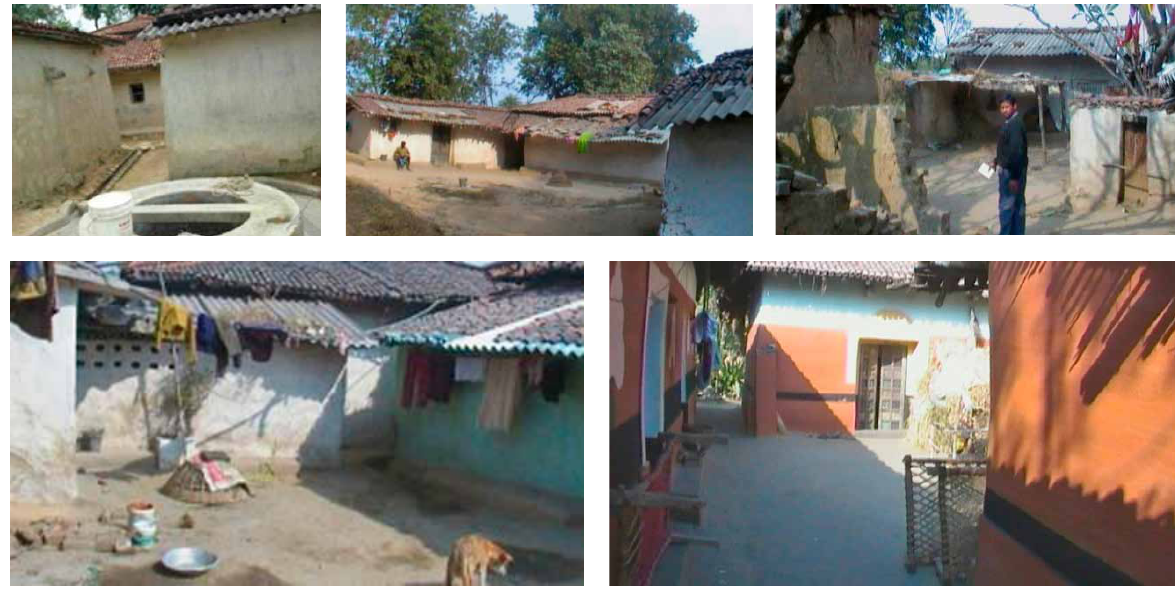
fig. 4. Some dwelling units with courtyards in ranchi’s composite climate Source: photographs by